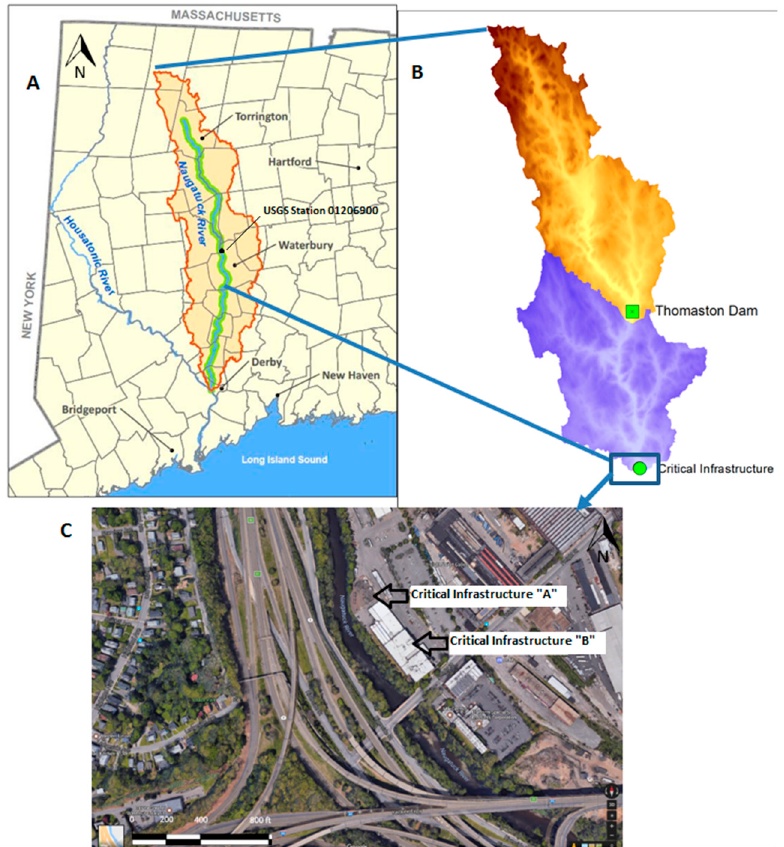
Figure 1 . ( a ) The Naugatuck River Basin, ( b ) the subdivision of the Naugatuck River Basin, ( c ) satellite imagery of critical infrastructure in Waterbury, Connecticut.